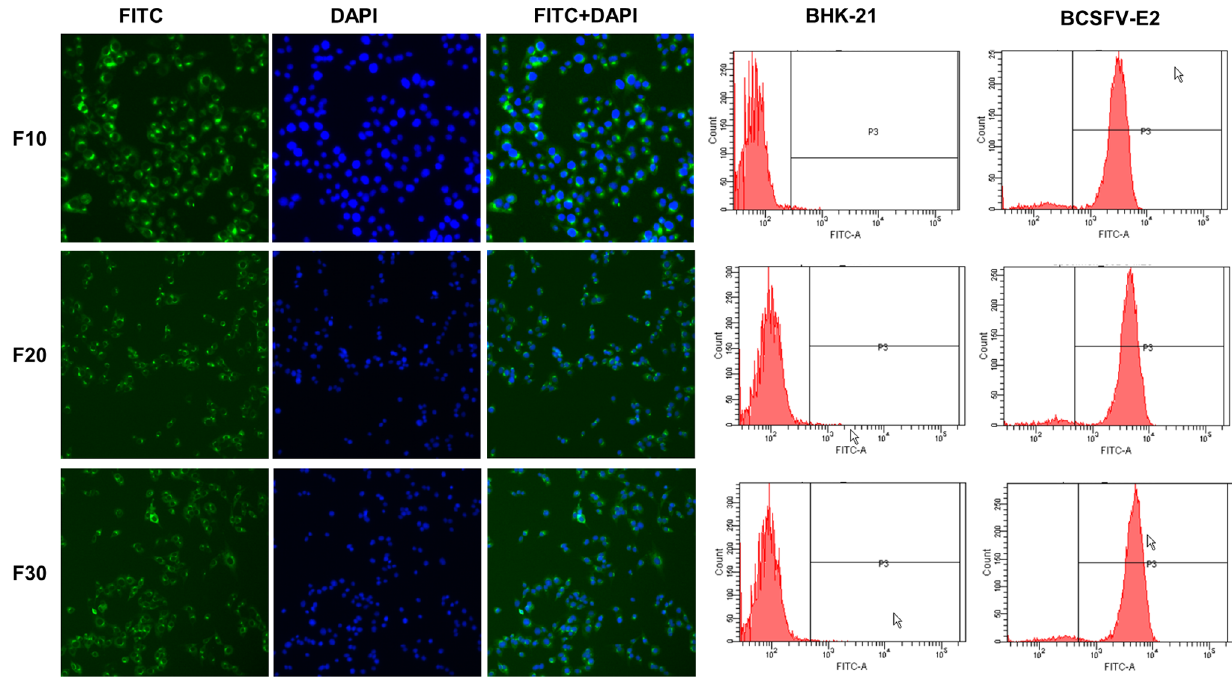
Figure 2. Immunofluorescence and flow cytometry analysis of BCSFV-E2 cell passages. The tenth (F10), twentieth (F20), and thirtieth (F30) generations of BCSFV cells were analyzed by indirect immunofluorescence and flow cytometry. Both assays show a high percentage of cells expressing CSFV E2.